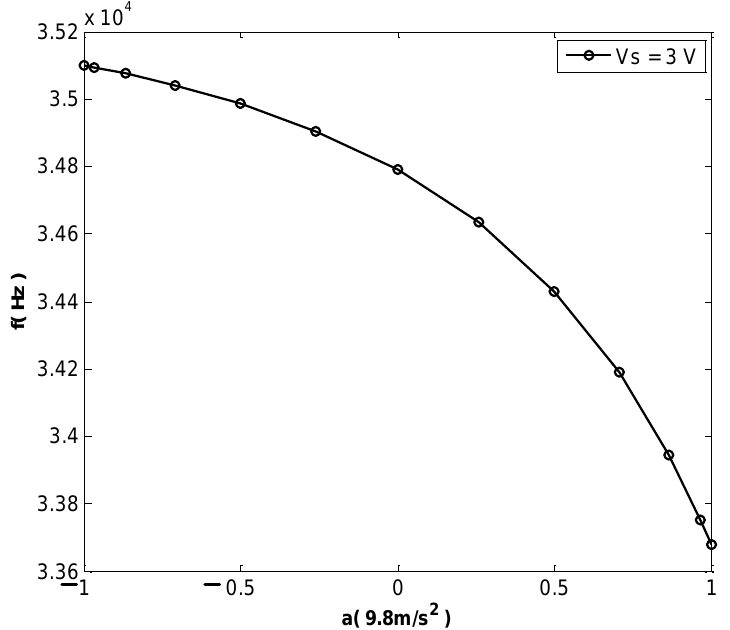
Figure 21. Output characteristic test (Vs = 3V).